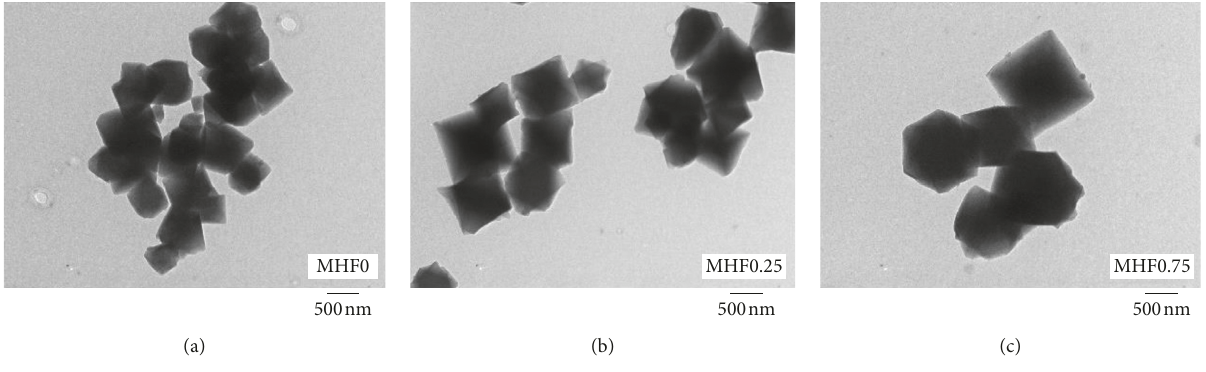
Figure 2: TEM images of MIL-101 synthesized with different molar ratios of HF/H